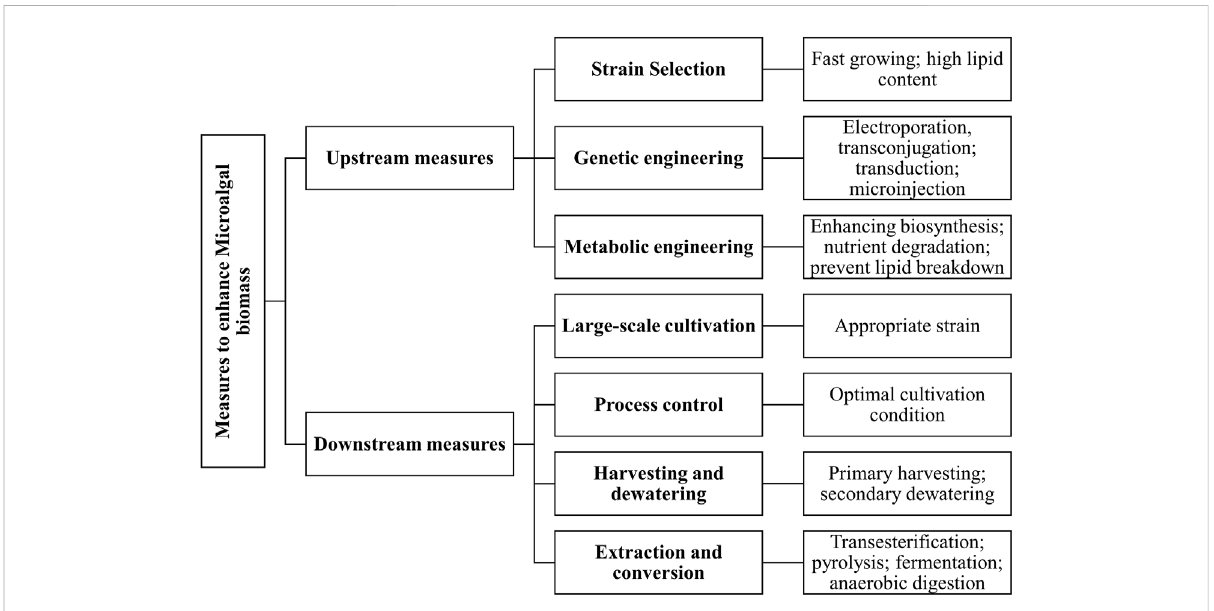
FIGURE 5 Different upstream and downstream measures to enhance microalgal biomass